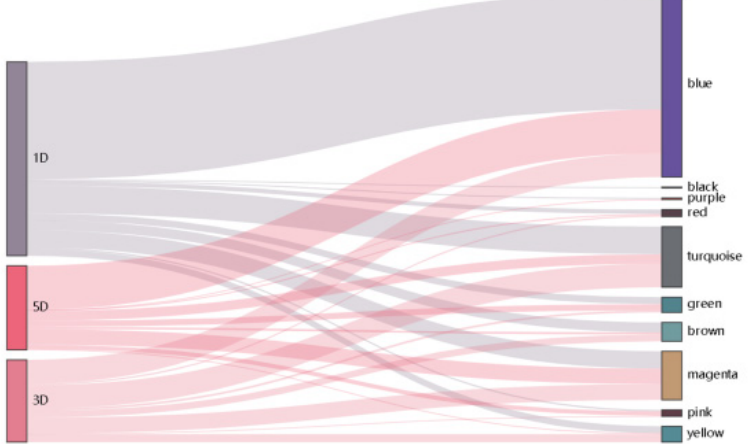
Figure 6. The Sankey diagram represents the distributions of DEGs in each module.